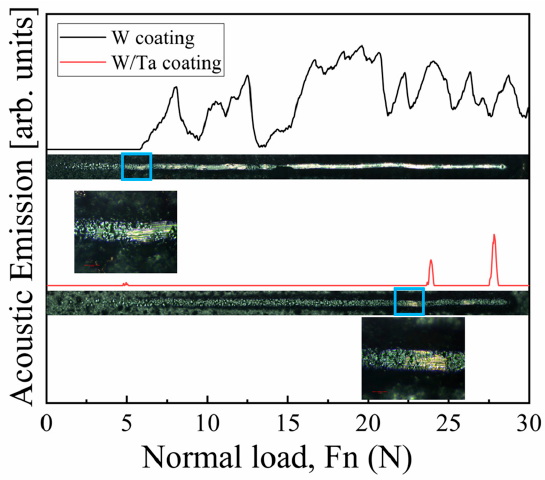
Coatings 2020 , 10 , x FOR PEER REVIEW Figure 6. The scratched morphology and the corresponding acoustic emission spectra.